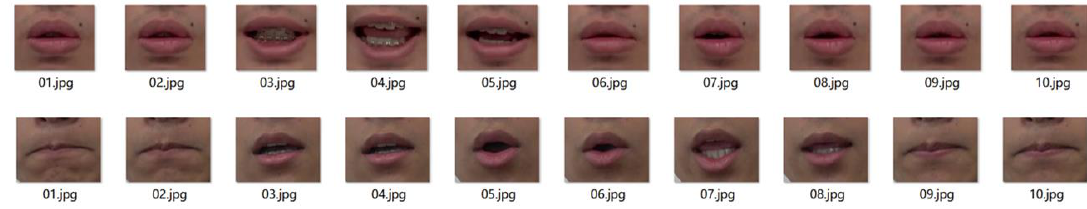
Figure 8. Lip motion map of the dataset.